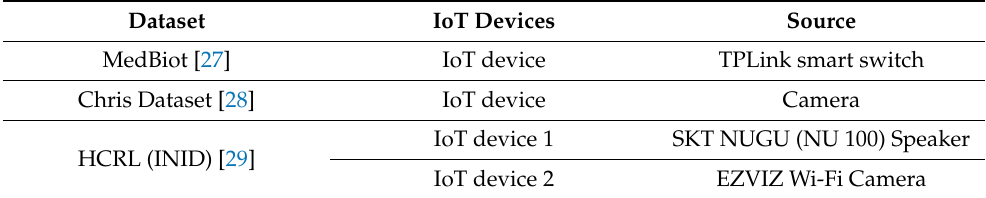
Table 3. Dataset